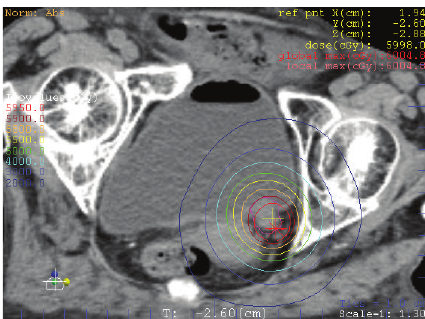
Figure 1: SBRT plan isodose line of case 1.